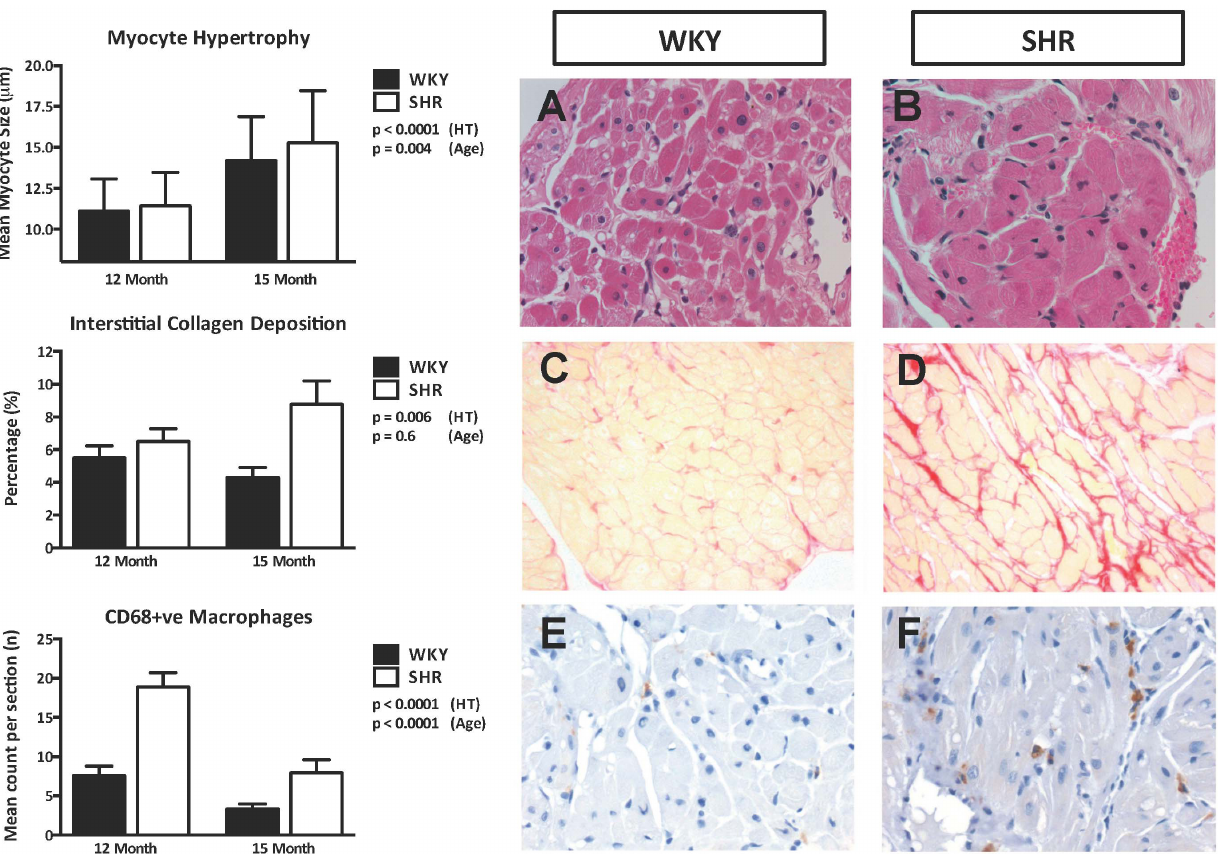
Figure 5. Atrial Structural Changes. Increased atrial myocyte dimension (Left, top panel), collagen deposition (Left, middle panel) and CD68- positive macrophages (Left, bottom panel) were seen with hypertension. Although ageing had no effect on atrial fibrosis, atrial myocyte hypertrophy was evident with lower CD68-positive macrophages count in both SHR and WKY with ageing. Representative H&E (Right, A & B, magnification 6 400), picrosirius red (Right, C & D, magnification 6 200) and CD68 immuno-stained sections (Right, E & F, magnification 6 200) are shown to demonstrate the atrial myocyte hypertrophy, increased amount of interstitial collagen deposition and CD68-positive macrophages in the 15 month-old SHR vs. WKY atria.